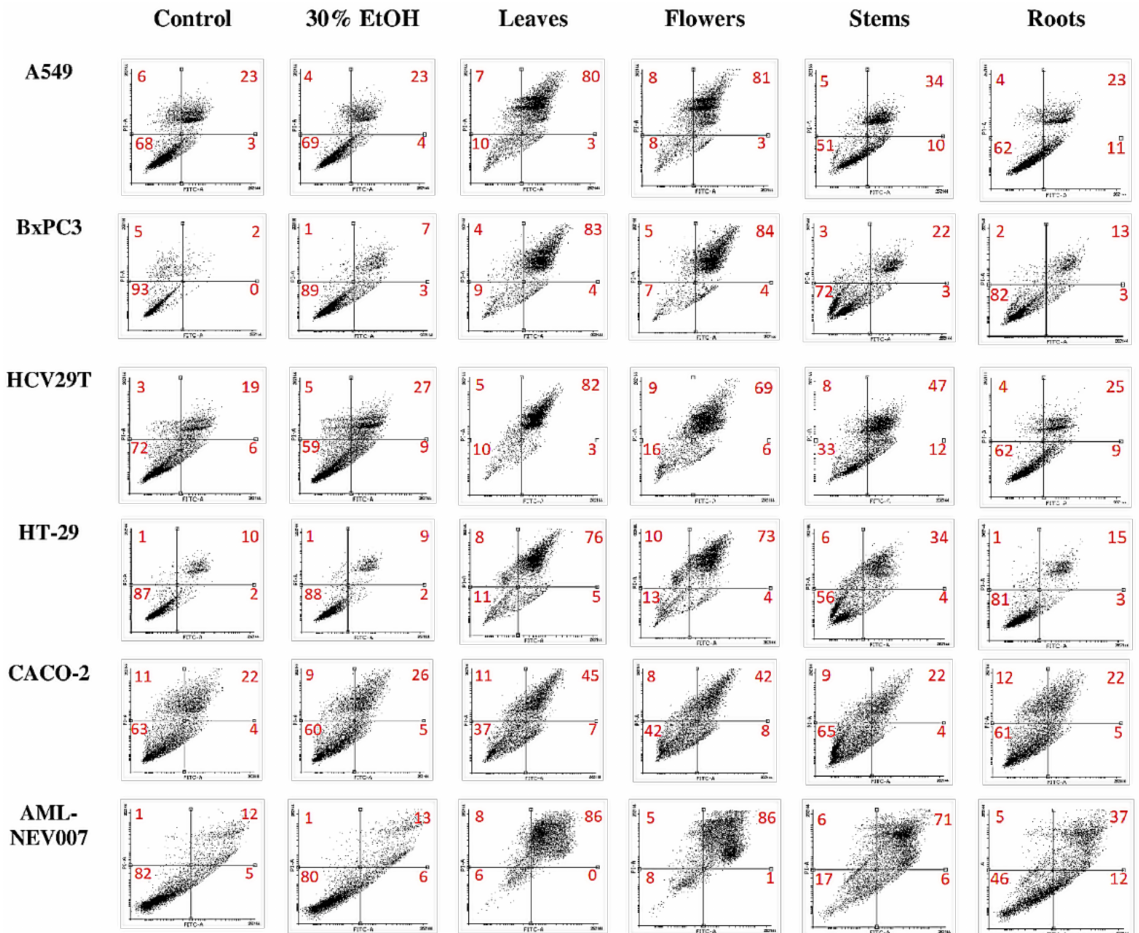
Figure 2. Induction of apoptosis after treatment for 48